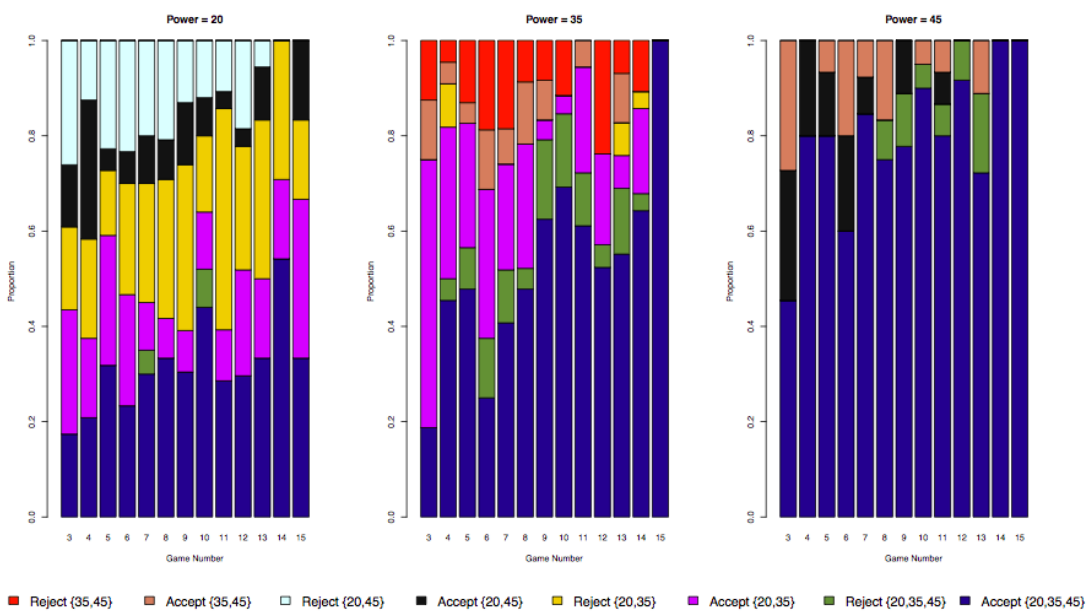
Figure 5. Percentage of responses at the start of every game, by game and agent’s